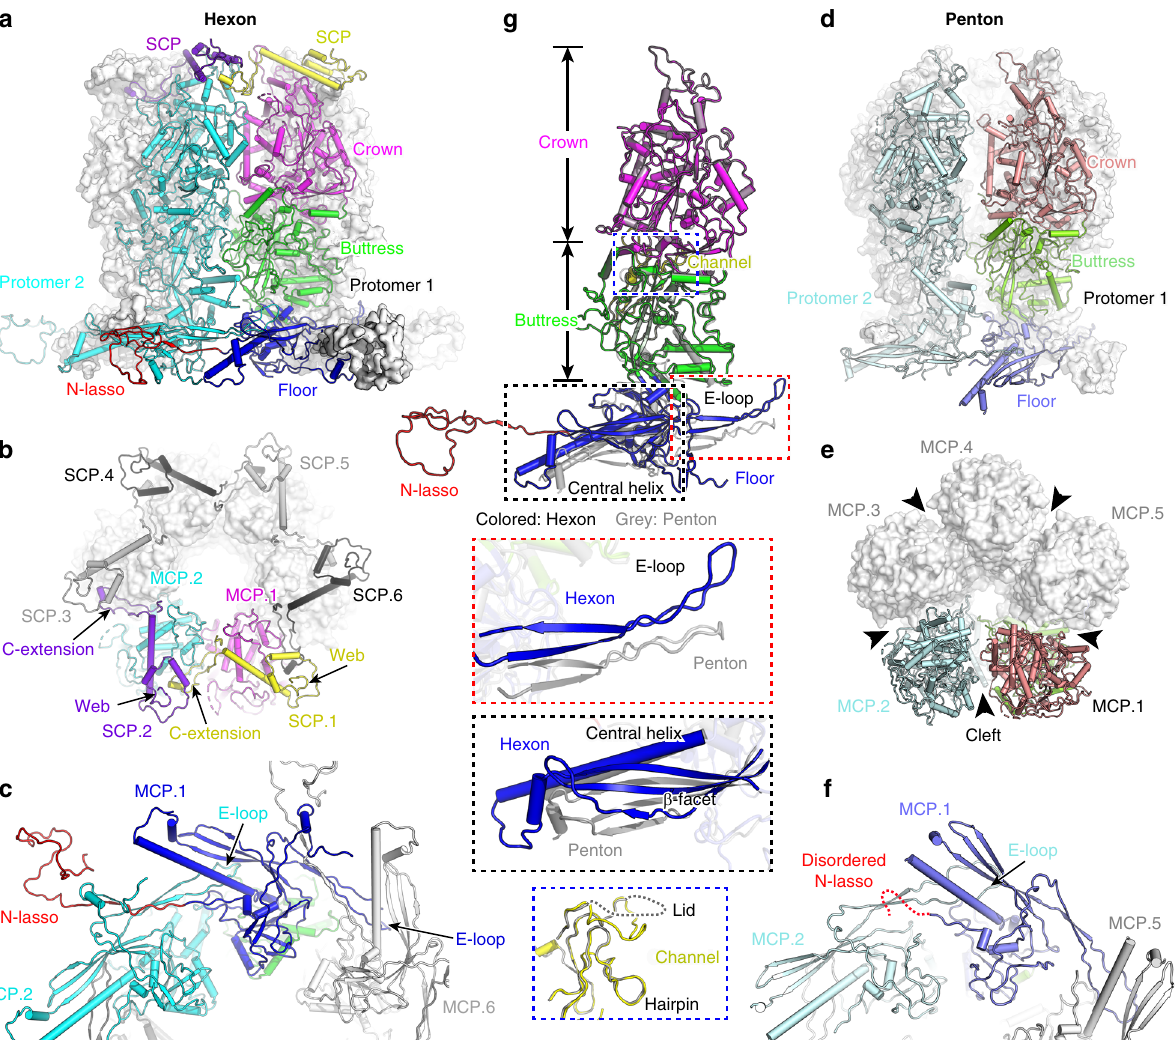
Fig. 2 Structures of MCP and SCP in different capsomers. a Overall structure of a hexon at the side view. Two adjacent MCP – SCP heterodimers are shown as cartoon models and the other four are shown as white surface models. One MCP is colored by domains and the other adjacent protomer is colored in cyan. The SCPs are colored by chains. b Top view of the hexon capsomer, revealing the contacting network of SCPs. c Bottom view of the basal fl oor interaction network in a hexon. d – f Architecture and inter-protomer interactions of a penton, shown in similar views and color schemes to those of the hexon in ( a – c ). g Superposition of the MCP conformers in hexon and penton capsomers. The insets show the close-up views of distinguished structural motifs with different conformations. The unresolved regions are represented by dashed